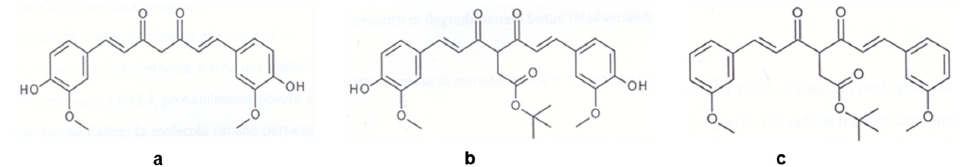
Figure 1. Structures of the investigated drugs loaded in the bioactive glasses: ( a ) curcumin; ( b ) K2T21; and ( c ) K2T23.